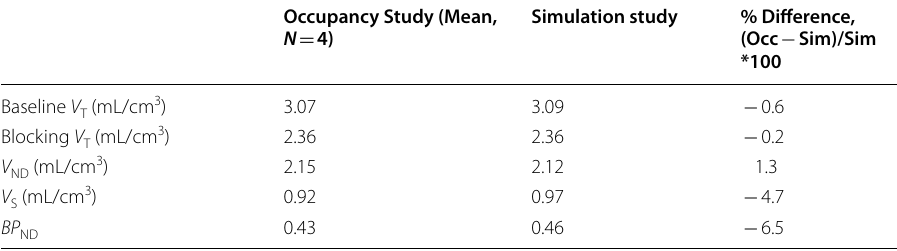
Table 2 Comparison of outcome measures between simulation study and occupancy study